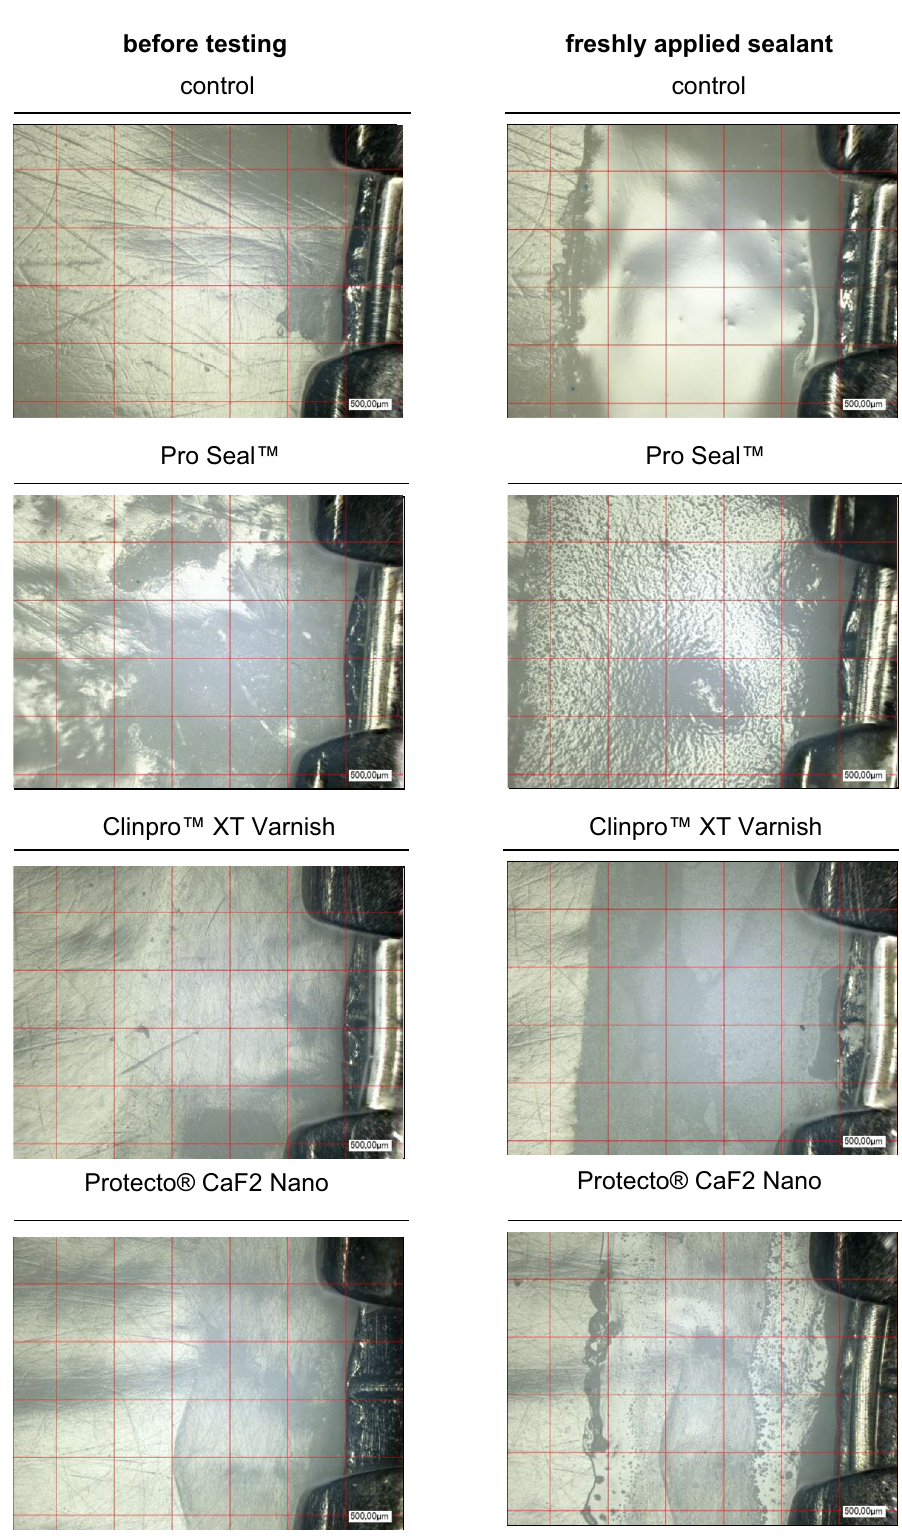
Figure 3. Boxplot diagram for the distribution of the relative score before and after the test under chemical